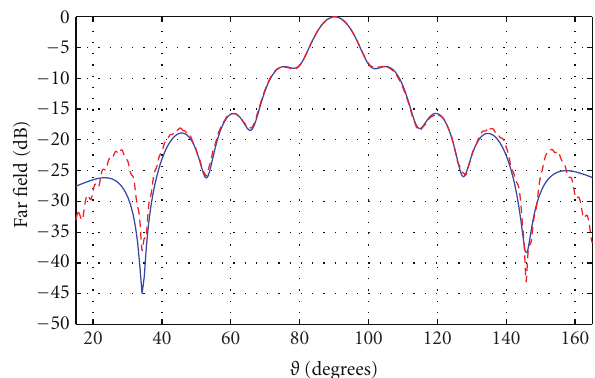
Figure 4: Single horn. Singular values.